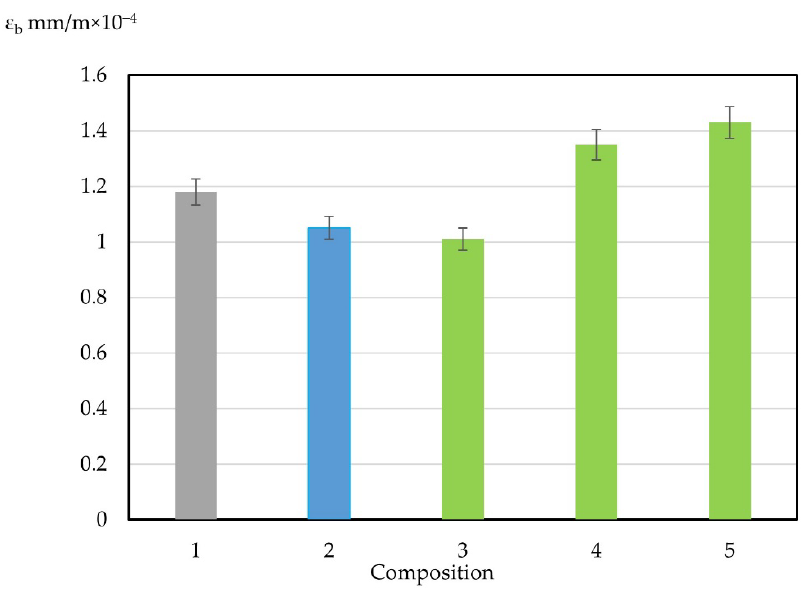
Figure 11. Change in ultimate strains during axial tension of concrete samples at the age of 28